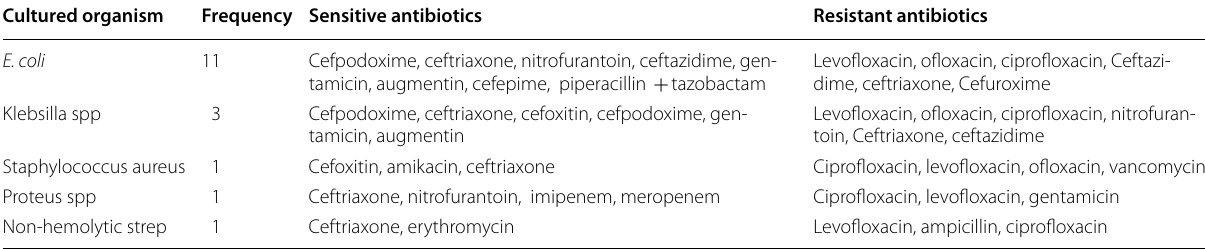
Table 3 Bacterial isolates in group 1 and antibiotic sensitivity pattern from urine culture Cultured organism